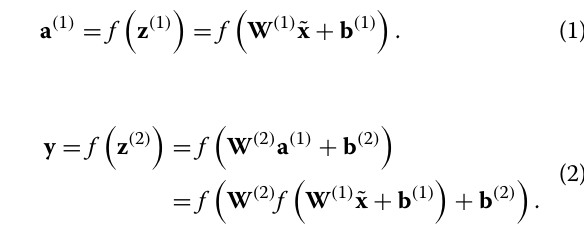
y = (cid:3) x is used, but linear measurements are not opti- mal. In the SSDAE_CS model, multiple nonlinear mea- surements are applied to obtain measurements in CS, as shown in the encoding part of Fig. 2. It is found from [25] that nonlinear measurements can preserve more effec- tive information compared to traditional linear measure- ments. The encoder consists of three layers, (a) an input layer with N nodes, (b) the first hidden layer with K nodes, and (c) the second hidden layer with M nodes, where N > K > M . The first hidden feature vector is the value of the first hidden layer, which receives the signals as its input in Eq. (1). The final measurement vector y is the value of the second hidden layer, which receives the first hidden feature vector as its input in Eq.